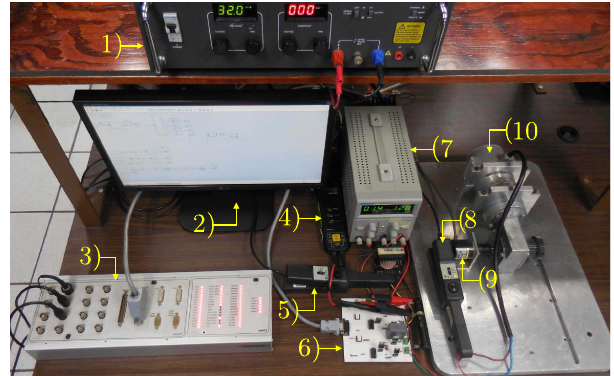
Figure 3. Photograph of the hardware used for the experimental tests of the full-bridge Buck inverter– DC motor system in closed-loop.